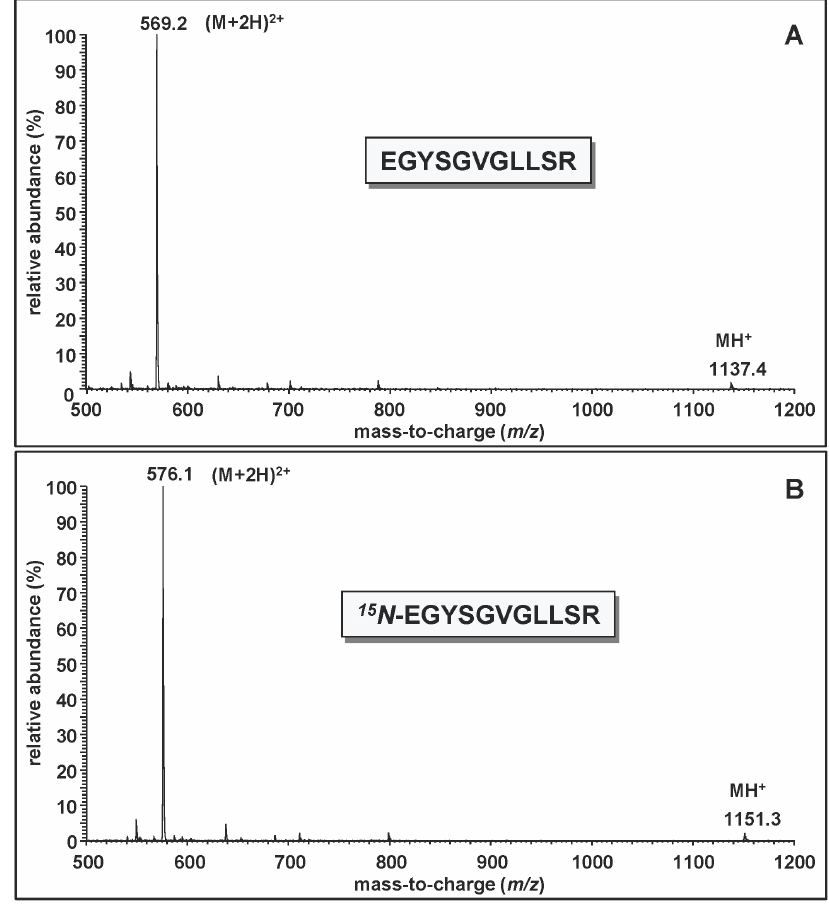
Figure 2. Full-scan mass spectra of EGYSGVGLLSR (A) (represented by peak 12 in Figure 1A) and 15 N-EGYSGVGLLSR (B) (represented by peak 12 in Figure 1B).